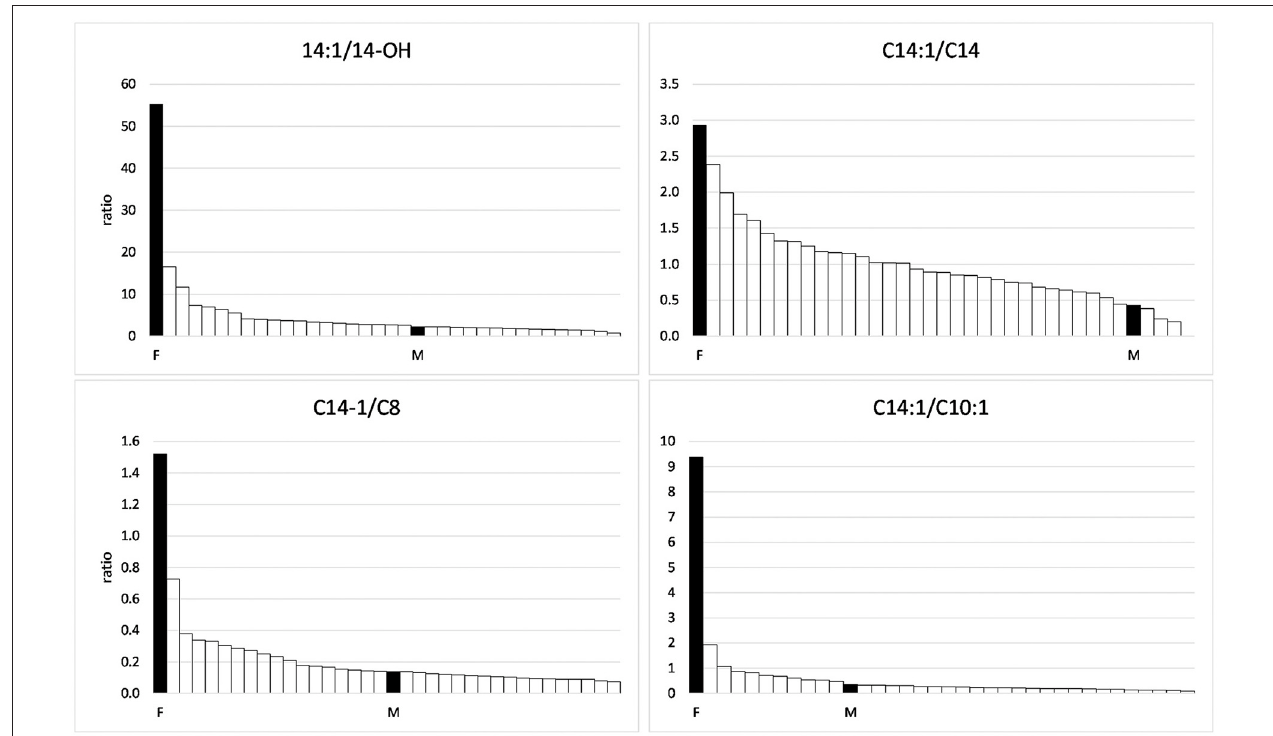
FIGURE 2 | Ratios of C14:1 to other acylcarnitines in the group of horses suffering from Atypical Myopathy including the foal (F) and the mare (M).